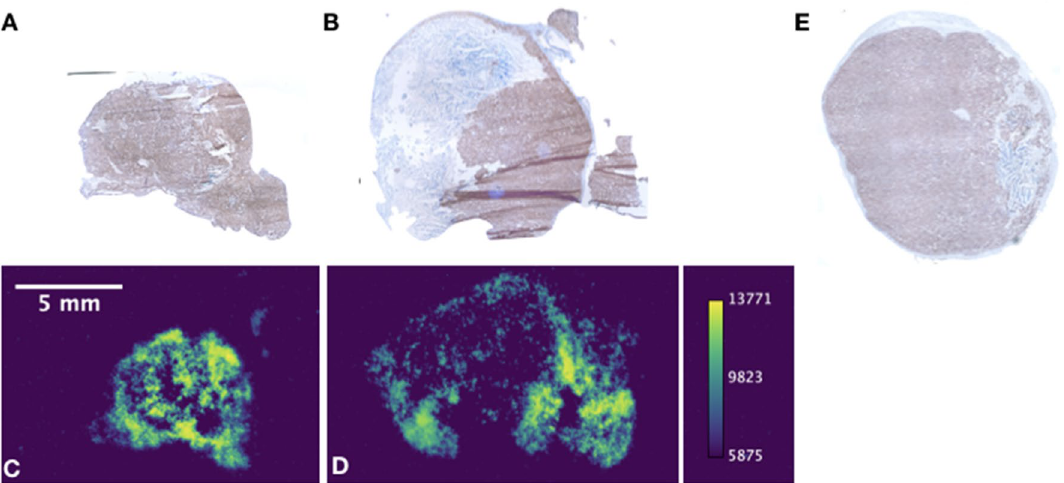
Figure 6. PARP-1 IHC and Autoradiography: Staining for PARP-1 was performed in tumors excised from treated and control animals. Autoradiographic images of tumor sections were acquired for [ 225 Ac]-PSMA-617 in the treatment group. The areas of intense PARP-1 staining in treated tumors ( A , C ) and alpha particle emitting therapeutic ( B , D ) generally correlate. Staining of tumors in the control saline-treated group ( E ) tended to be less intense, but there was no significantly discernible difference in PARP-1 expression by IHC at this late sacrifice time